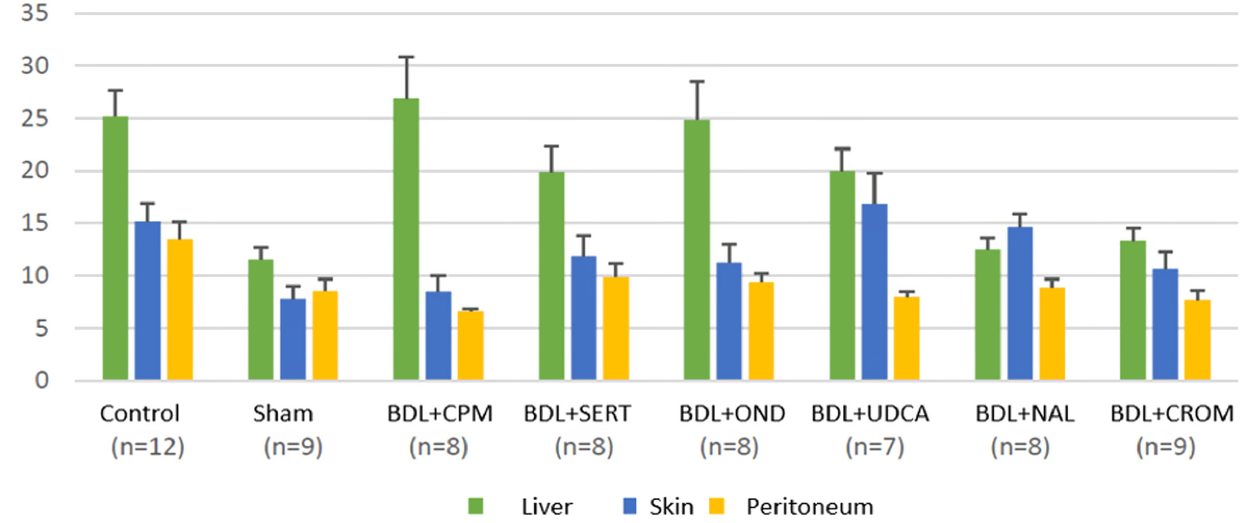
Figure 6. Mast cell counts in the liver, the skin, and the